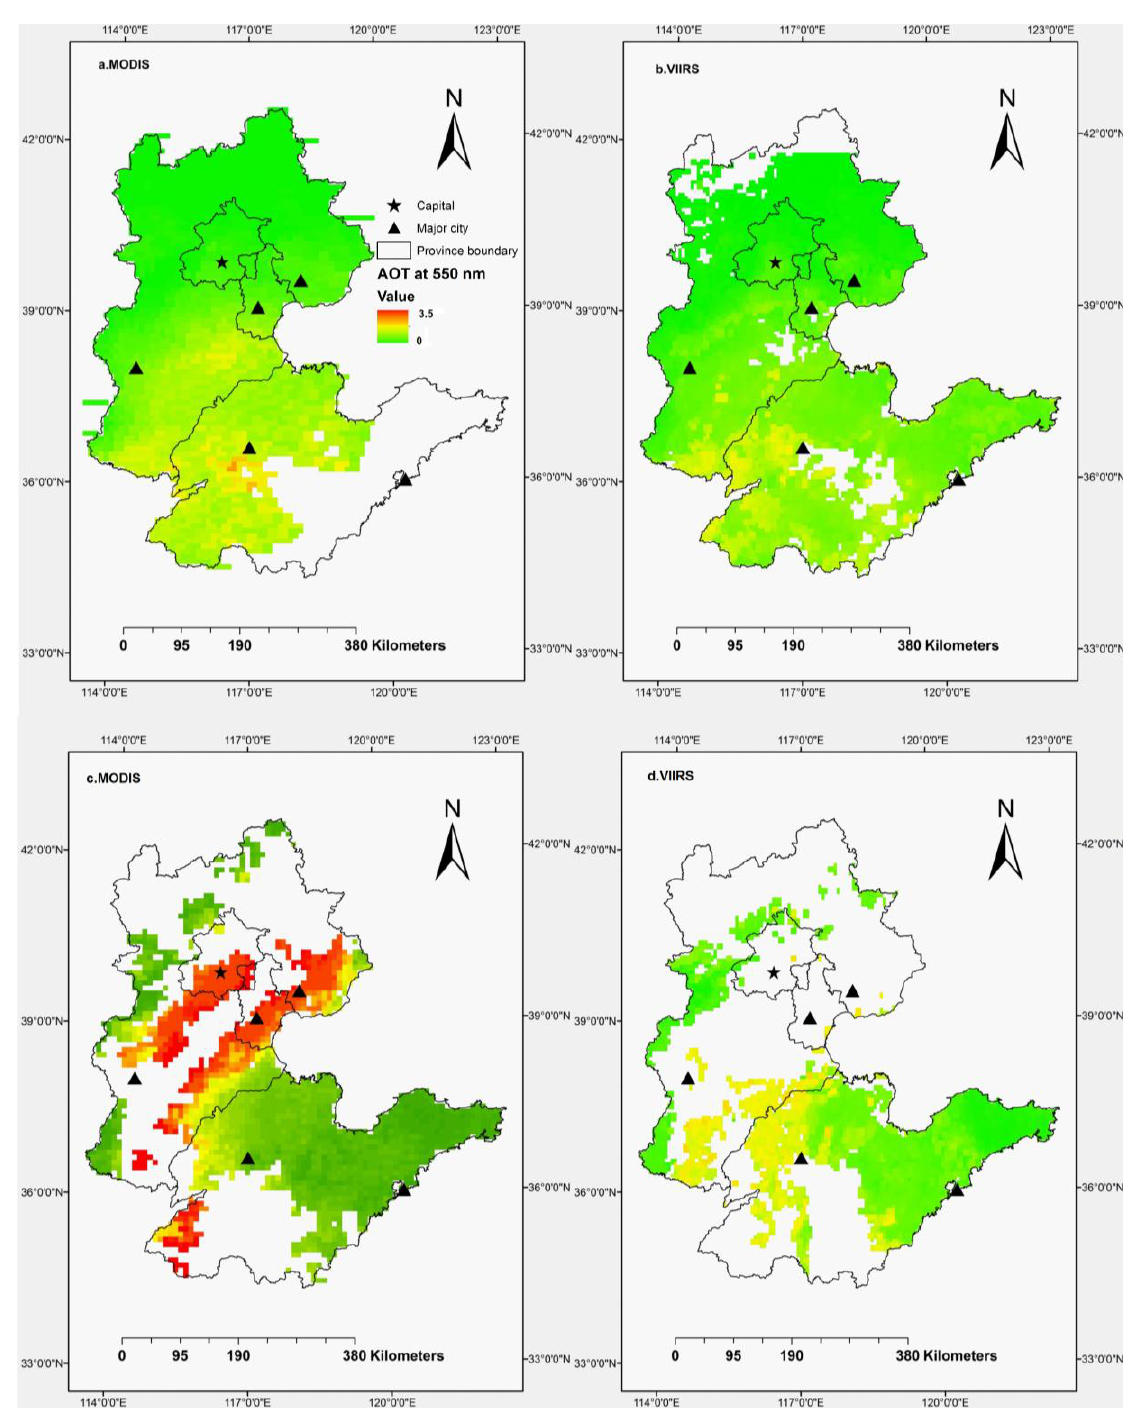
Figure 6. Satellite-retrieved AOT during and after the 2014 Beijing APEC Meetings in the study area. ( a , b ). 9 November 2014 ( c , d ). 26 November 2014 (both dates have stagnant atmospheric